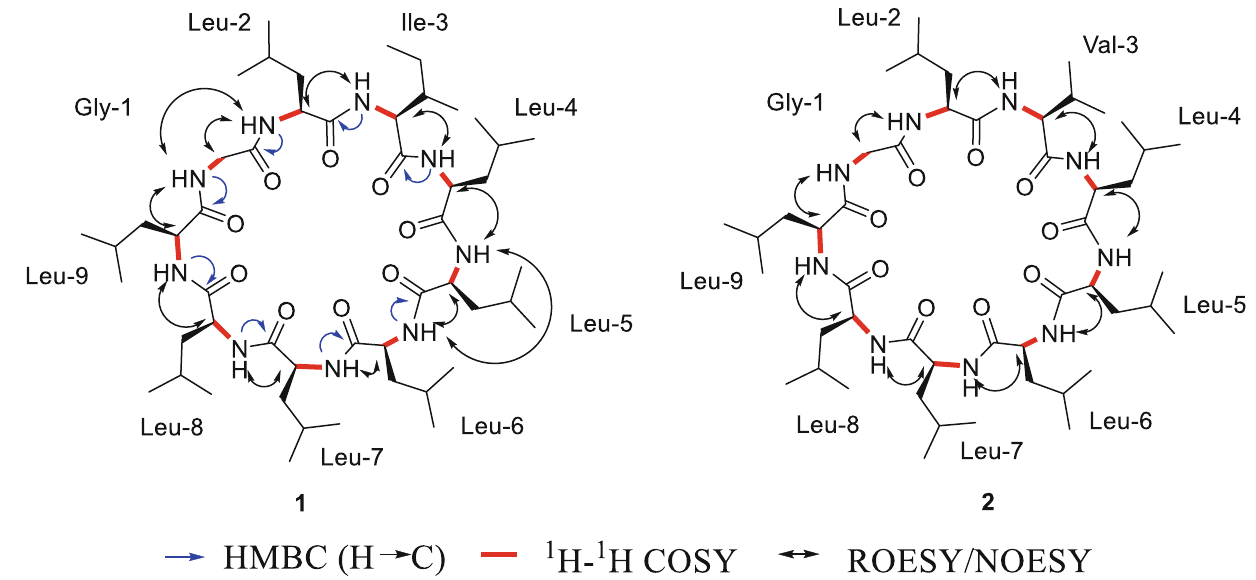
Fig. 3 Key HMBC, 1 H- 1 H COSY, and ROESY/NOESY correlations of 1 and